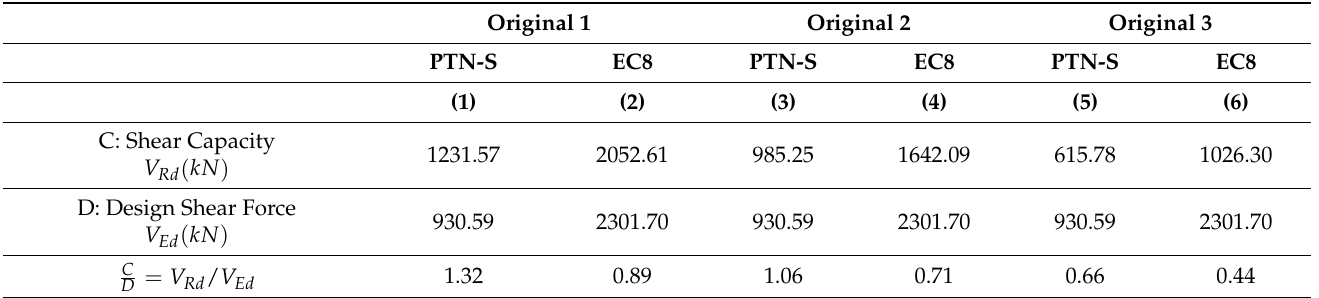
Table 4. Comparison of seismic capacity (C) and demand (D) at the ground floor level of the building in N–S direction (for the original structure).